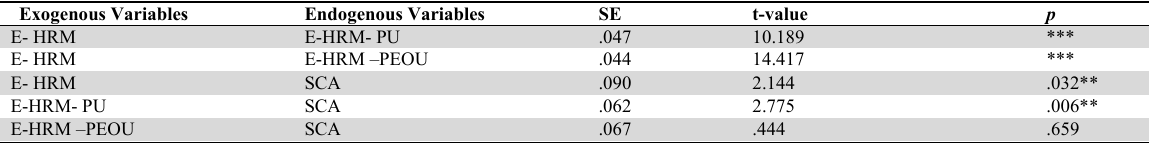
Maximum likelihood estimates for the research model.